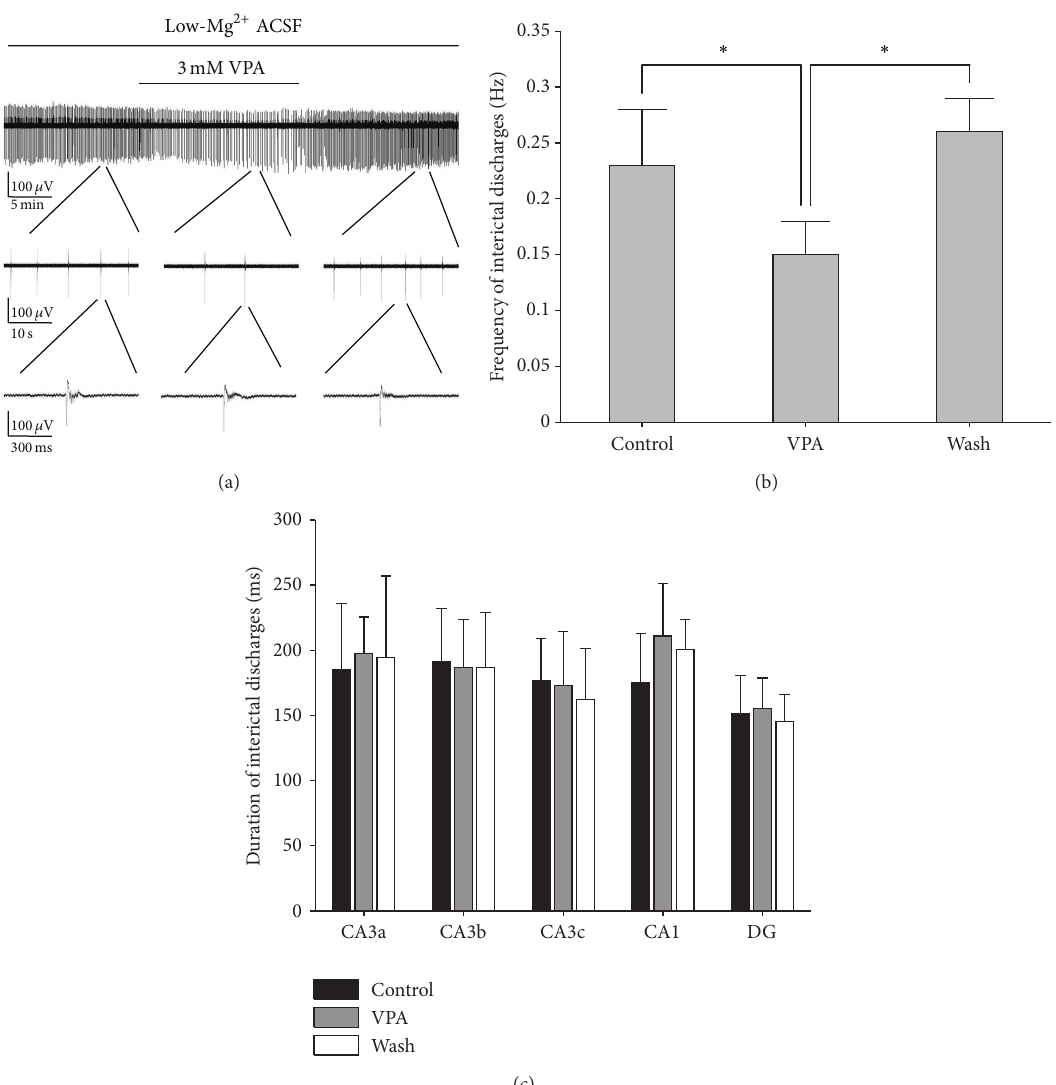
Figure 6: Effects of VPA on low-Mg 2+ -induced interictal discharges in hippocampal slices. (a) Long-term display of the epileptiform discharges before, during, and after 3 mM VPA application, which represented the recordings of electrode number 87 in the CA3b region (Figure 1(a)). (b) Effects of VPA on interictal discharge frequency. There were significant differences between the VPA group and the Control/Wash ( ∗ 𝑃 < 0.05 , ANOVA, 𝑛 = 5 ). (c) Effects of VPA on interictal discharge duration. There were no significant differences between the VPA group and the Control/Wash ( 𝑃 > 0.05 , ANOVA, 𝑛 = 5 ).